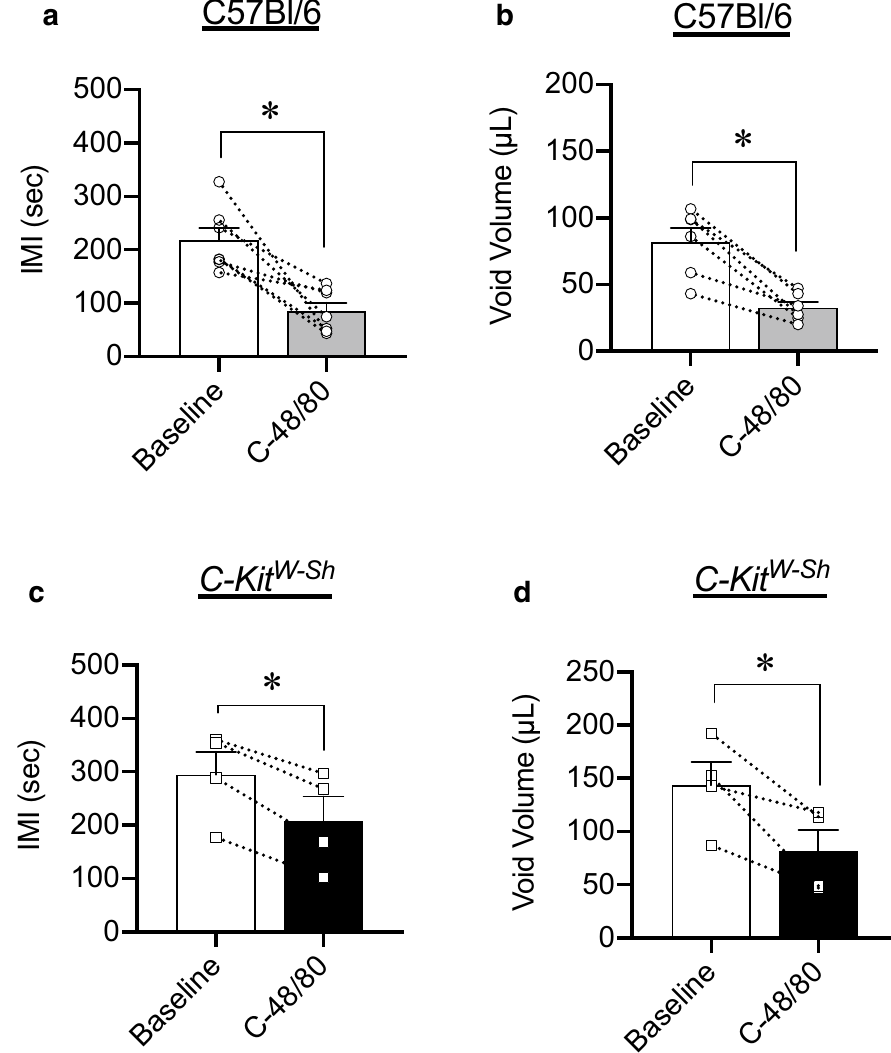
Figure 8. Compound 48/80 decreases causes bladder overactivity in wild-type and mast cell-deficient mice. Intravesical instillation of Compound 48/80 (50 µg/mL) significantly decreased intermicturition interval ( a ) ( P = 0.005) and void volume ( b ) ( P = 0.002) in C57Bl/6 mice (N = 8) during conscious cystometry. ( c , d ) Compound 48/80 had the same effect on intermicturition interval and void volume in mast cell-deficient C-kit W-Sh mice ( P = 0.005 and P = 0.04, N = 4). Within the group comparisons were made via paired Student’s